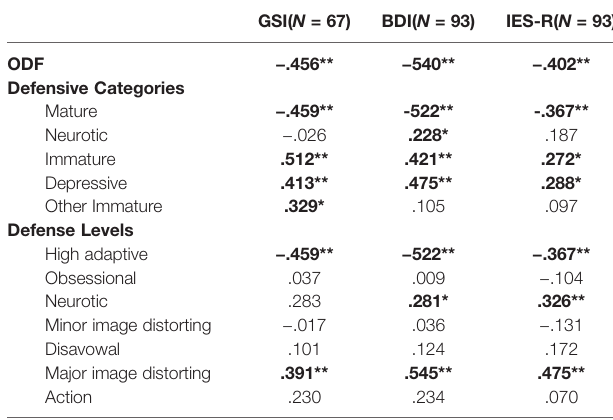
TABLE 6 | Convergent validity calculated as correlations between 30-item Defense Mechanism Rating Scales Self-Report (DMRS-SR-30) subscales and psychological distress